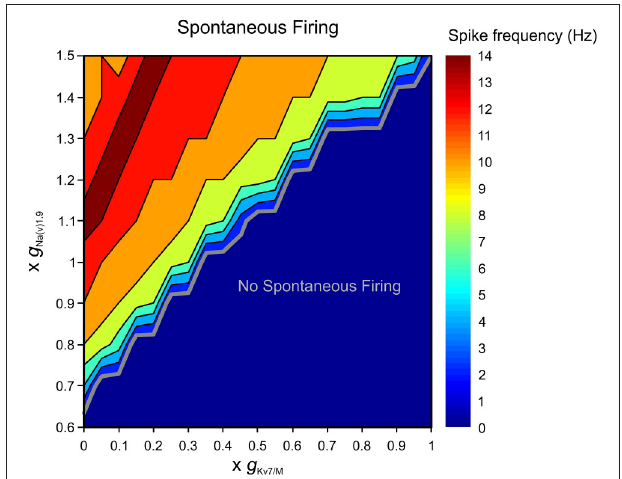
FIGURE 8 | Terminal g Kv7 / M opposes g Na(v)1.9 in preventing spontaneous firing. Graphic representation of the relationship between the terminal g Kv7 and g Na(v)1.9 in eliciting spontaneous firing of multi-compartmental model of nociceptive neurons. The recordings performed at the proximal axon of the modeled neuron ( blue electrode in Figure 4 ). The thick gray line outlines the range of g Kv7 and g Na(v)1.9 beneath which no spontaneous activity occurs ( blue area ). The frequency of the spontaneous activity is color coded (shown on the right ). Note that when g Terminal Kv7 / M is intact, spontaneous firing can be elicited only when g Na(v)1.9 is increased above 140%. Note also that when g Terminal Kv7 / M is annulled, at least 65% of g Na(v)1.9 is required to induce spontaneous